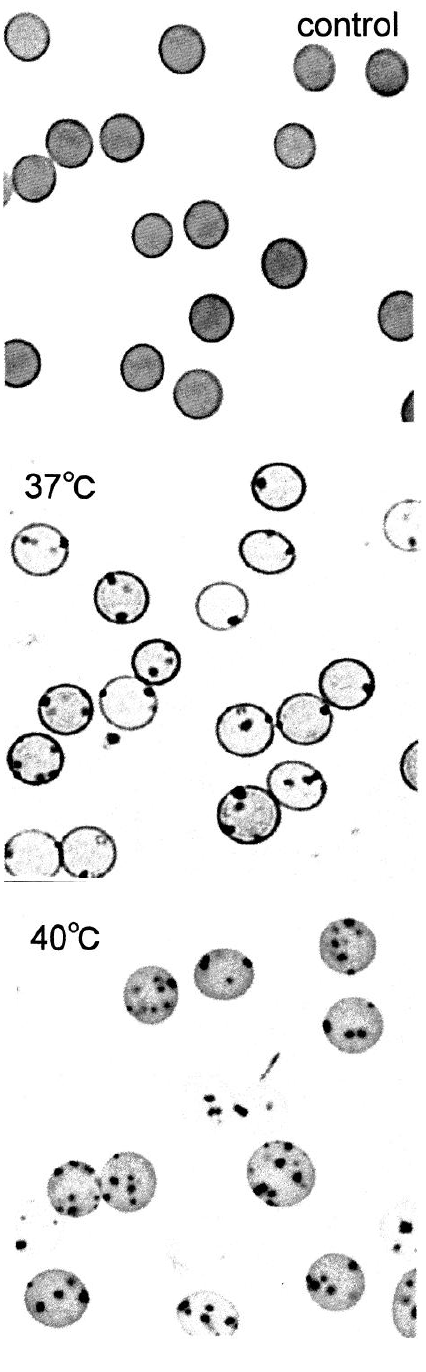
Figure 3. Microscopic views of Heinz bodies after mild heating of blood samples obtained from one healthy donor, redrawn from Sugawara et al. [14]. Using a temperature-untreated sample as a control, aliquots of freshly drawn venous blood were subjected to mild heating at 37 °C, 40 °C, 42 °C, 45 °C or 48 °C for 30 min. Heinz bodies were then visualized by exposure to acetylphenylhydrazine and dyeing with crystal violet. The changes that occurred within erythrocytes were observed by light microscopy under